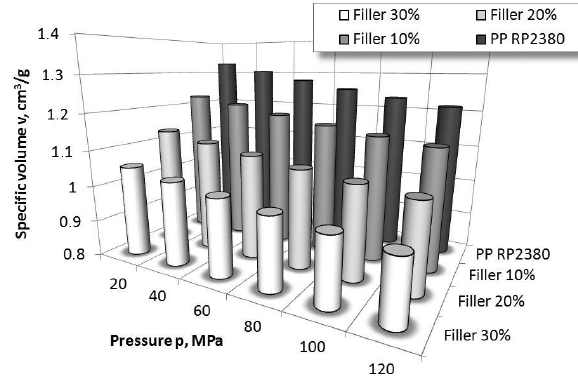
Figure 5: Changes of specific volume depending on the pressure and the filler content at ambient temperature (25 ∘ C) paring the decrease in the specific volume v at 10% and 30% filler contents, it can be observed that it is close to 13.7% when the pressure ranges from 20MPa to 100MPa, while at 120MPa it slightly increases to 13.9%. The filler content does not affect the temperature of transition from solid to melt state; with increasing the filler content the transition temperature is 402.60K, 402.62K and 402.38K, respectively.